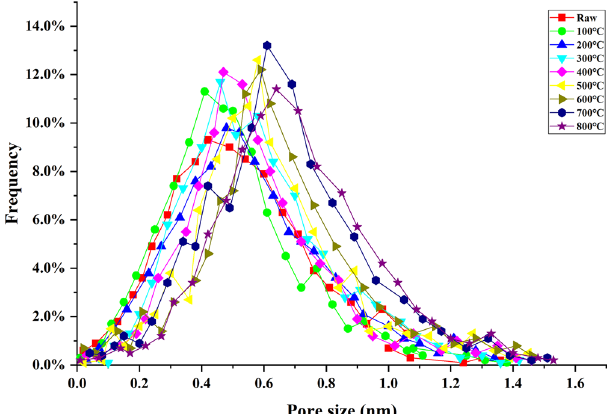
Figure 7. Pore size distribution of the heat treatments.